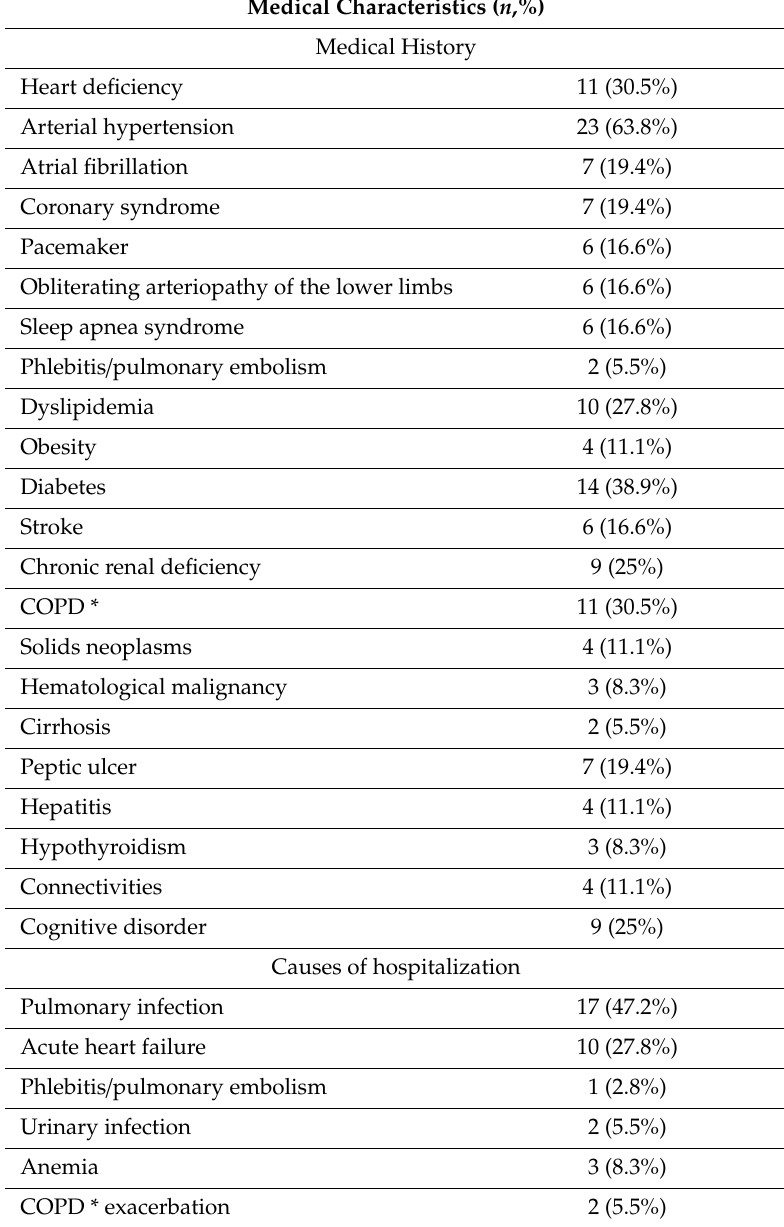
Table 5. Characteristics of the study population ( n =